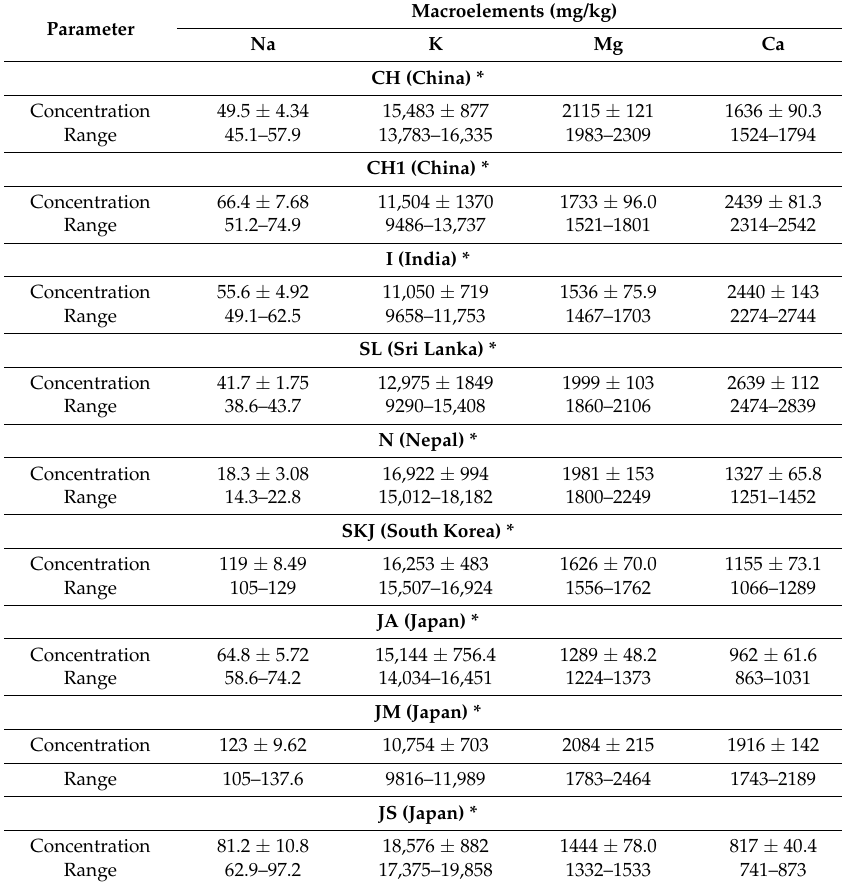
Table 2. The average content of macroelements in green tea samples according to their origin (including tea type or